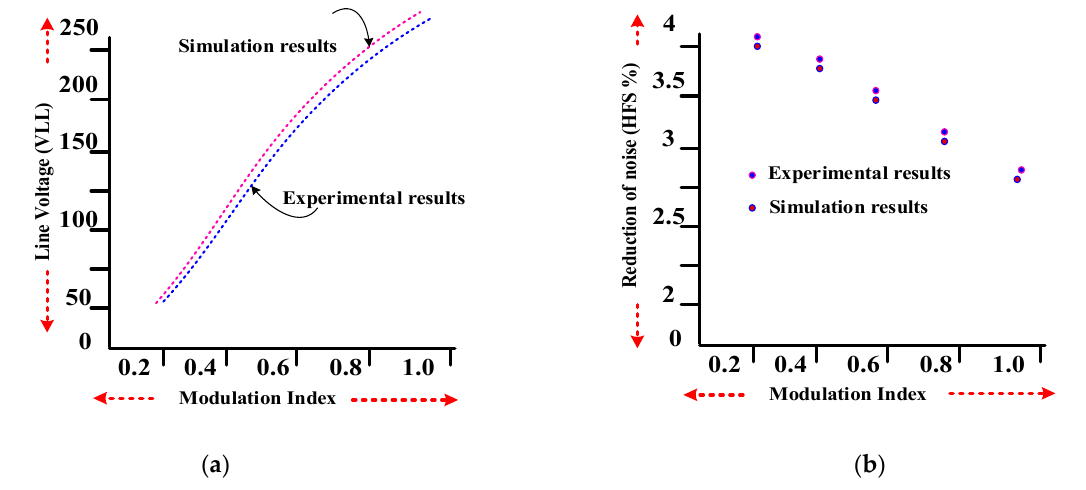
Figure 14. Comparisons of simulation and experimentation: ( a ). Line voltage versus modulation index, ( b ) Reduction of noise (HFS %) versus modulation index.